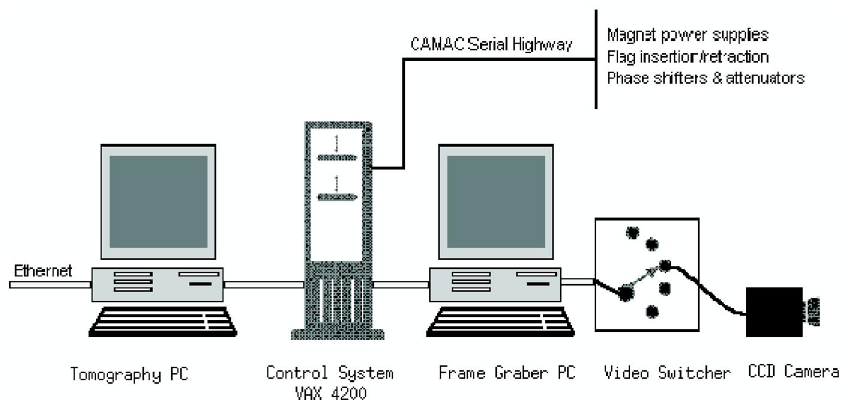
FIG. 6. (Color) Schematic representation of the computer hardware used in this